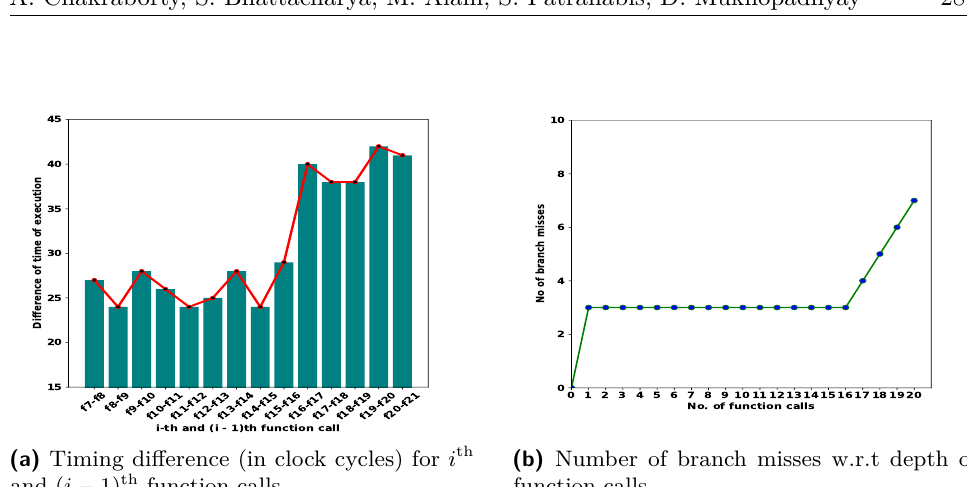
Figure 3: Variation of (a) timing and (b) branch misses shows the capacity of